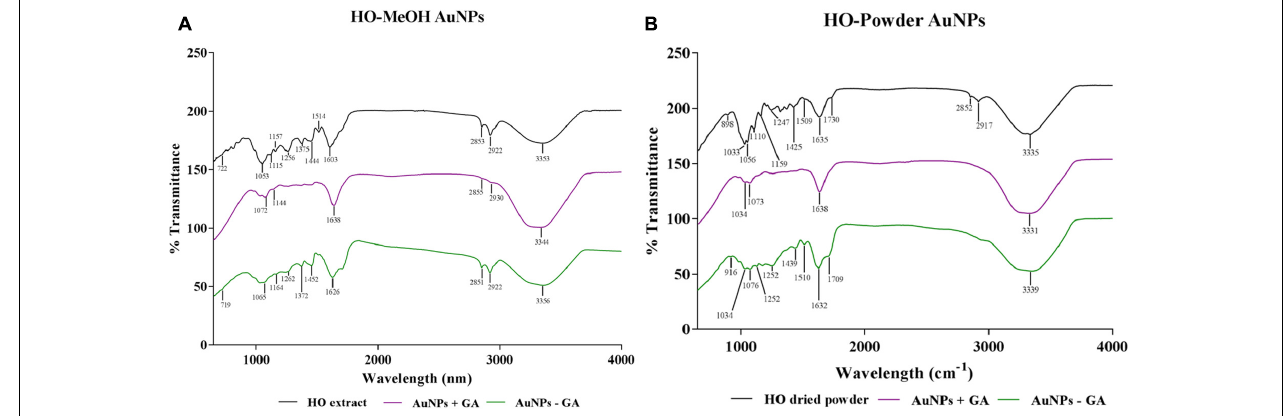
FIGURE 5 | Fourier Transform Infrared spectra of Helichrysum odoratisimum methanol extract (A) and H. odoratissimum leaf powder (B) gold